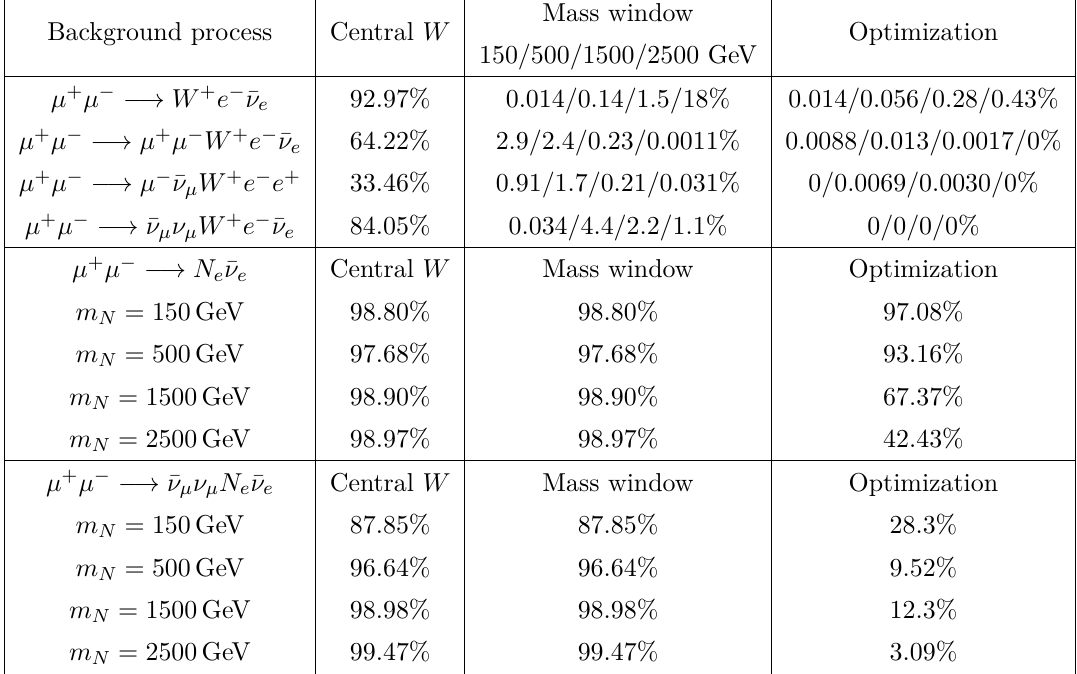
Table 16 . Cutflow table for N e at 3 TeV. All processes after pre-selection is set to